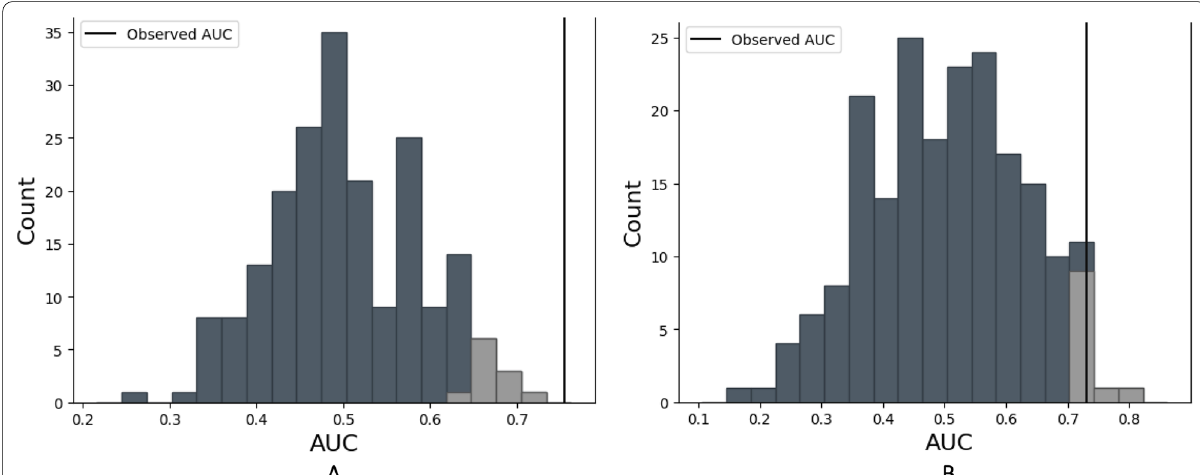
Fig. 1 A generated null distribution of AUC values from a permutation test where the class labels (e.g., patients with bipolar disorder and healthy controls) are randomly shuffled 200 times and an AUC value for each permutation is plotted. The light grey region represents the critical area with the 5% largest values. The vertical lines represent the observed AUC values from the true class labels. A Generated null‑distribution for the Random Forest classification of patients with bipolar disorder against healthy control individuals. B Generated null‑distribution for the Random Forest classification of patients with bipolar disorder against unaffected